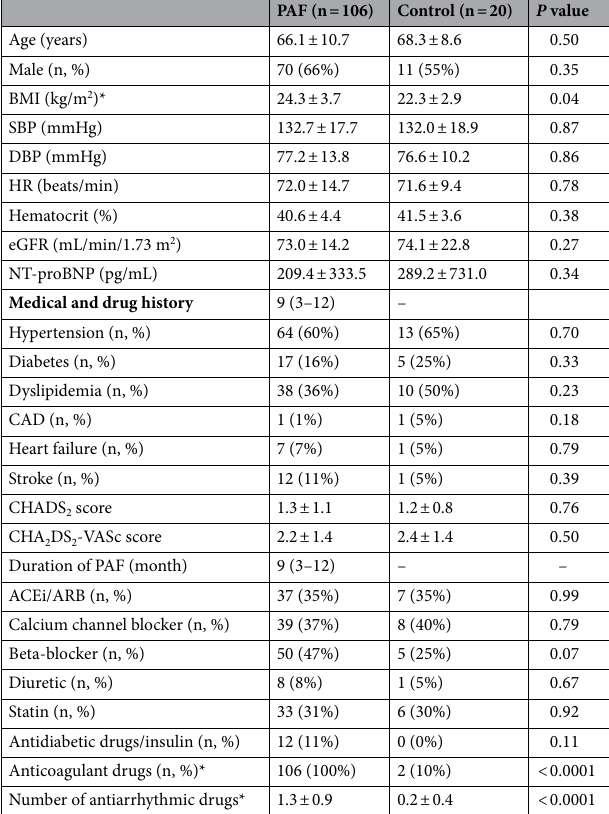
Table 1. Demographic data of the PAF and control groups. All data are shown as mean ± standard division, median (interquartile range), or number of participants (percentages), as appreciate. ACEi angiotensin-